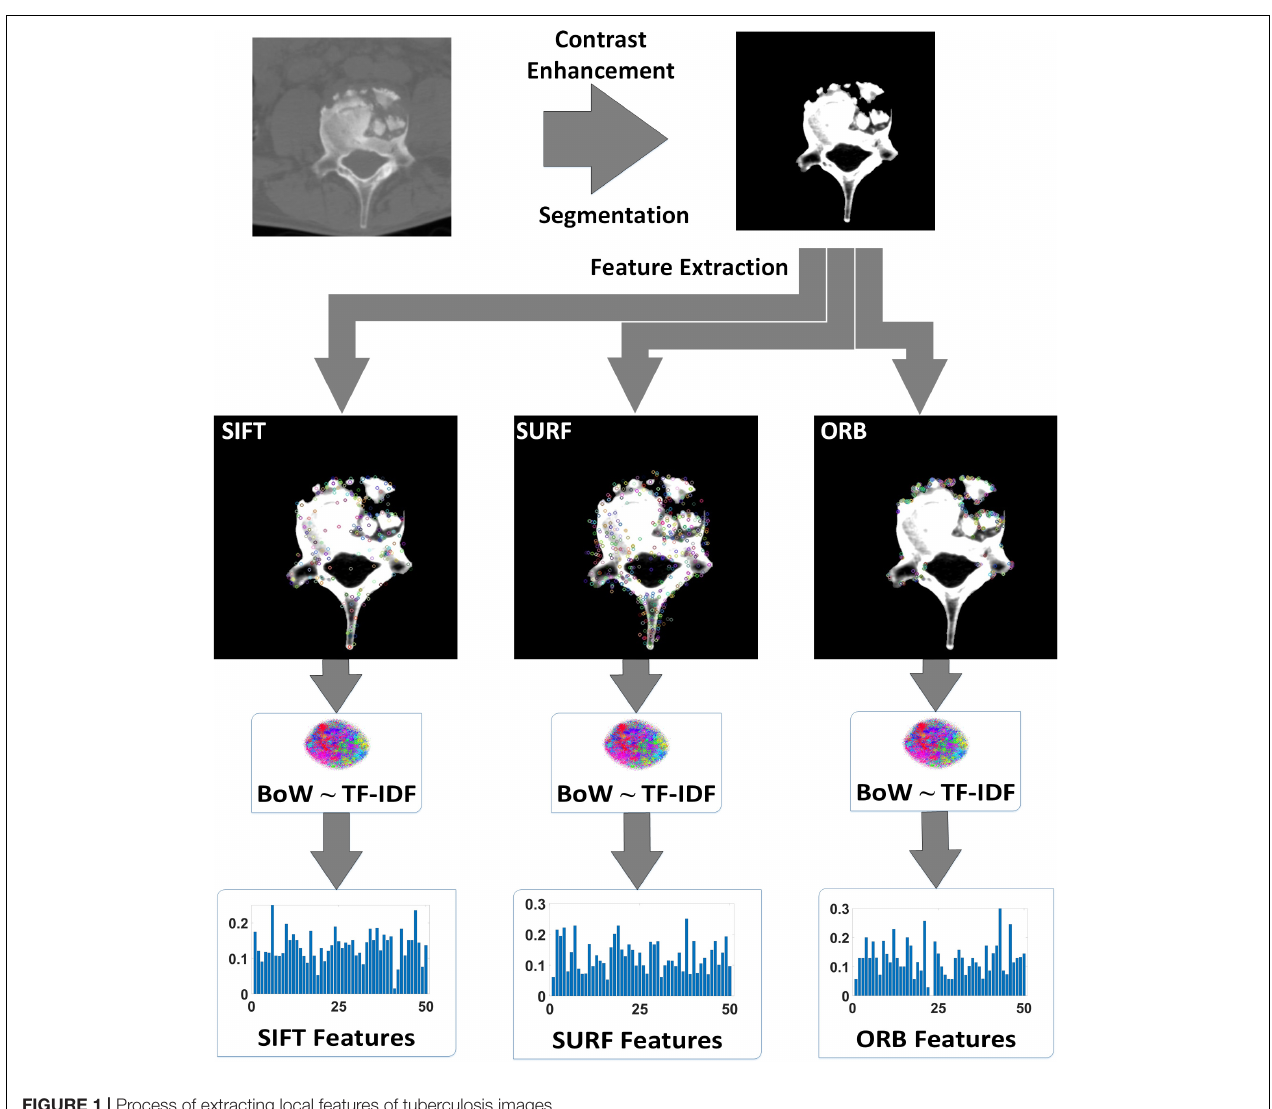
FIGURE 1 | Process of extracting local features of tuberculosis images.